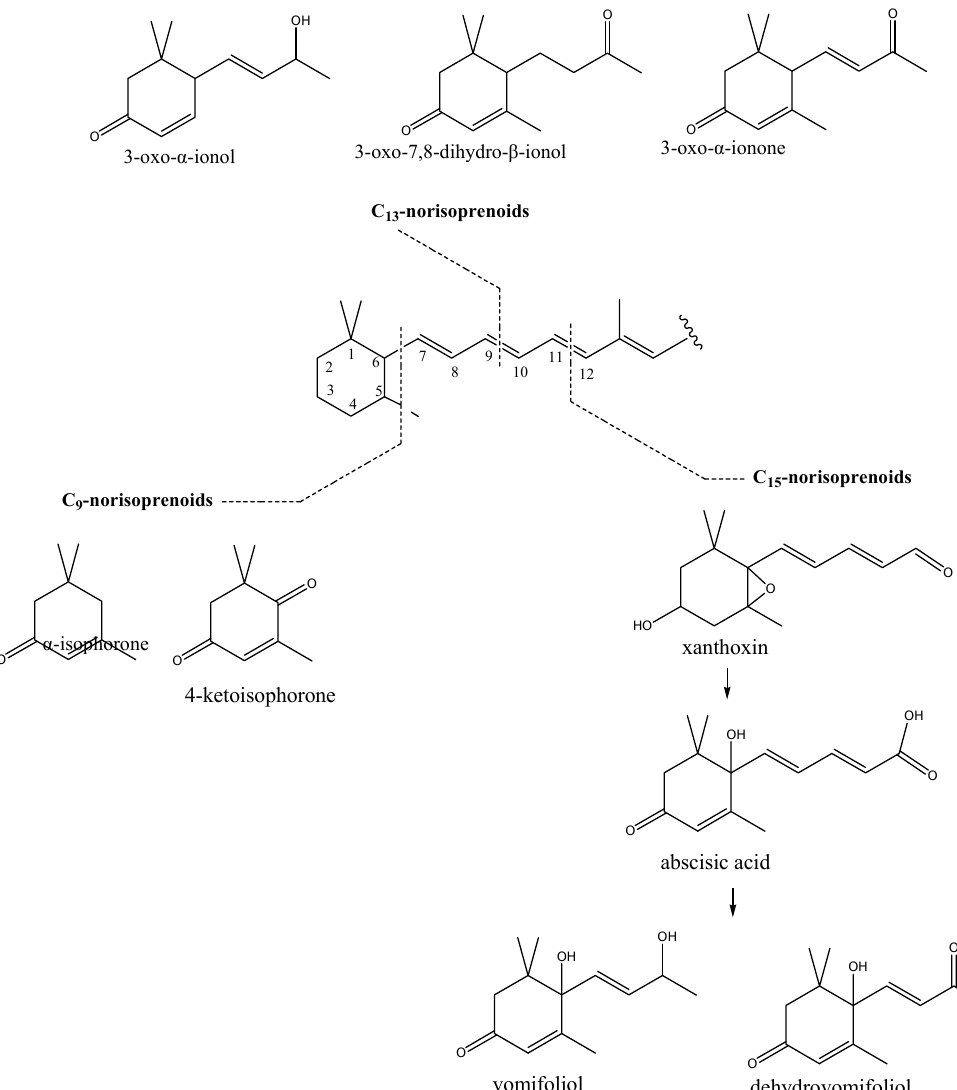
, C and C 9 13 15